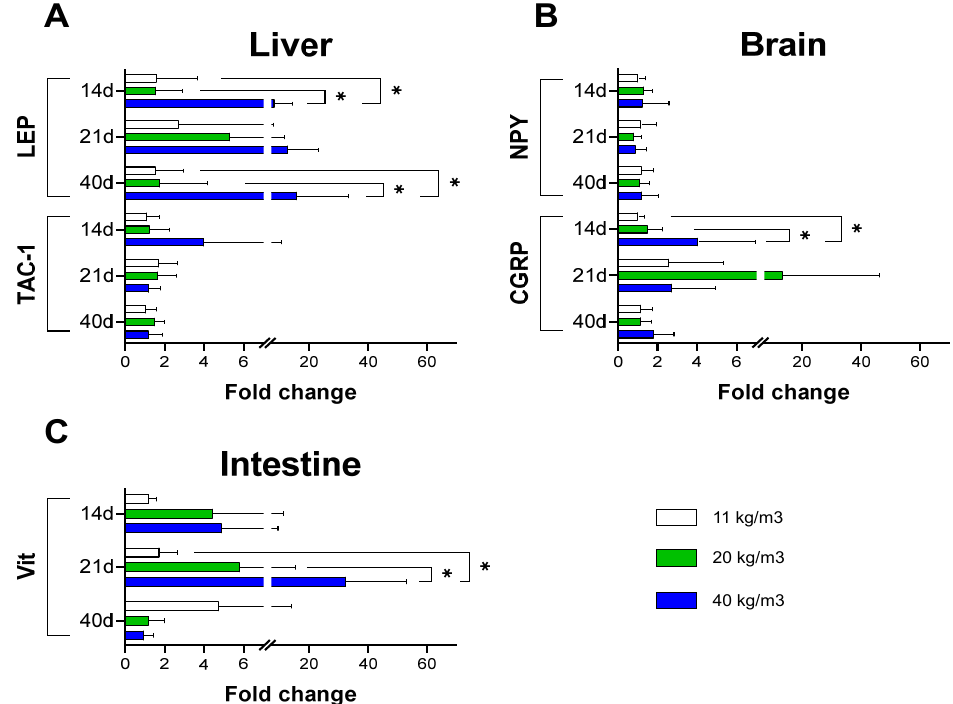
Figure 5. Relative expression of peptide hormones of brain, liver, and intestine of S. salar post-smolts cultured at different initial stocking densities. Effect of stocking density on Leptin and TAC-1 mRNA expression in liver on ( A ), NPY and CGRP mRNA expression in brain ( B ), and VIP mRNA expression in intestine ( C ). Bars represent mean ± SD (n = 12). Asterisks show significant differences among stocking densities groups ( p < 0.05, two-way ANOVA, followed by Tukey’s test).